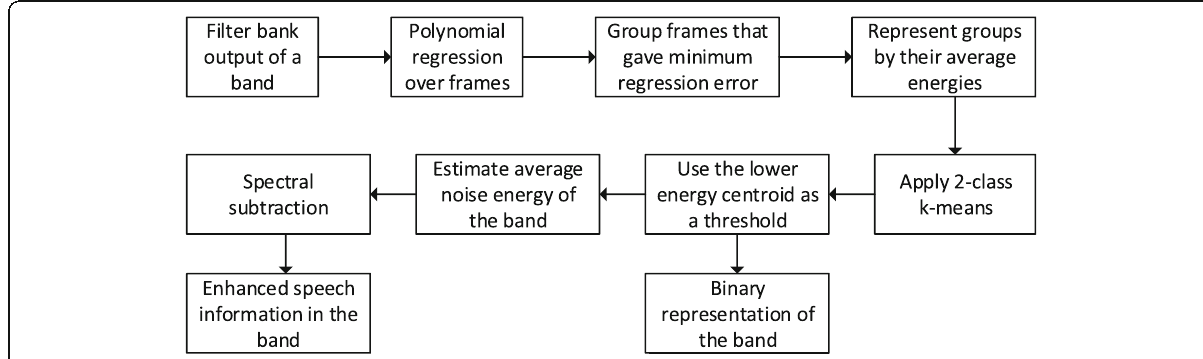
Fig. 4 Block diagram of the processes to observe enhanced speech information and binary representation of the frames in a given